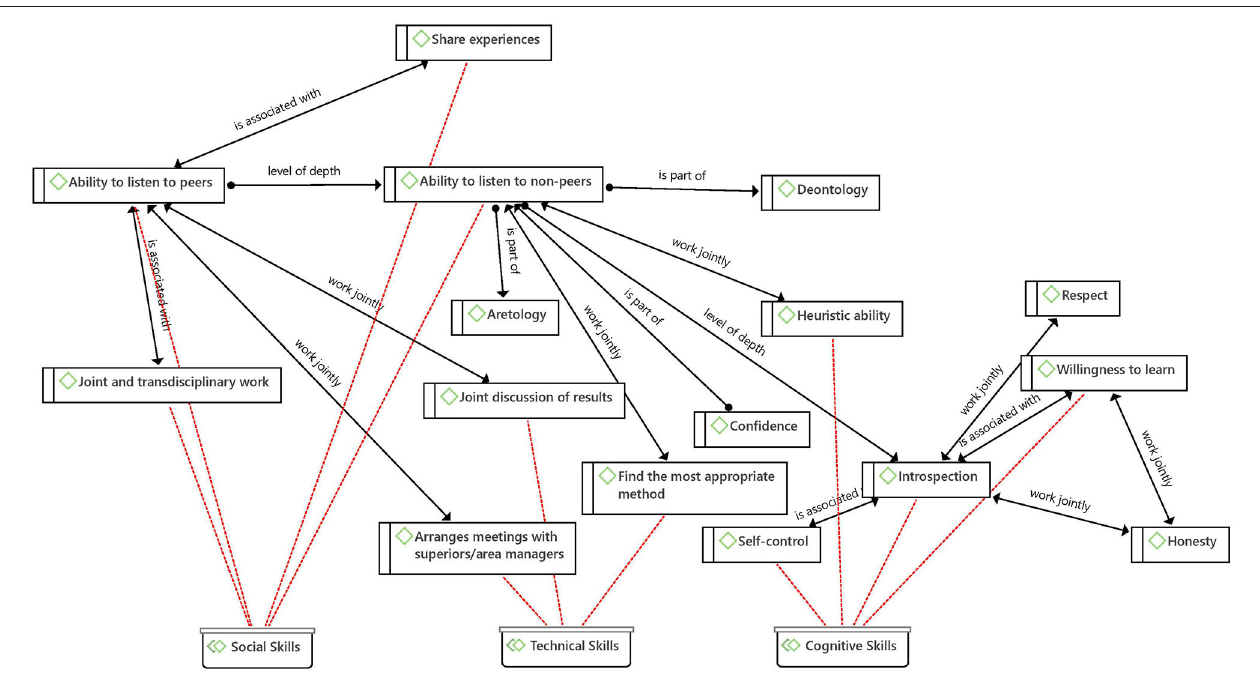
FIGURE 10 | The network of